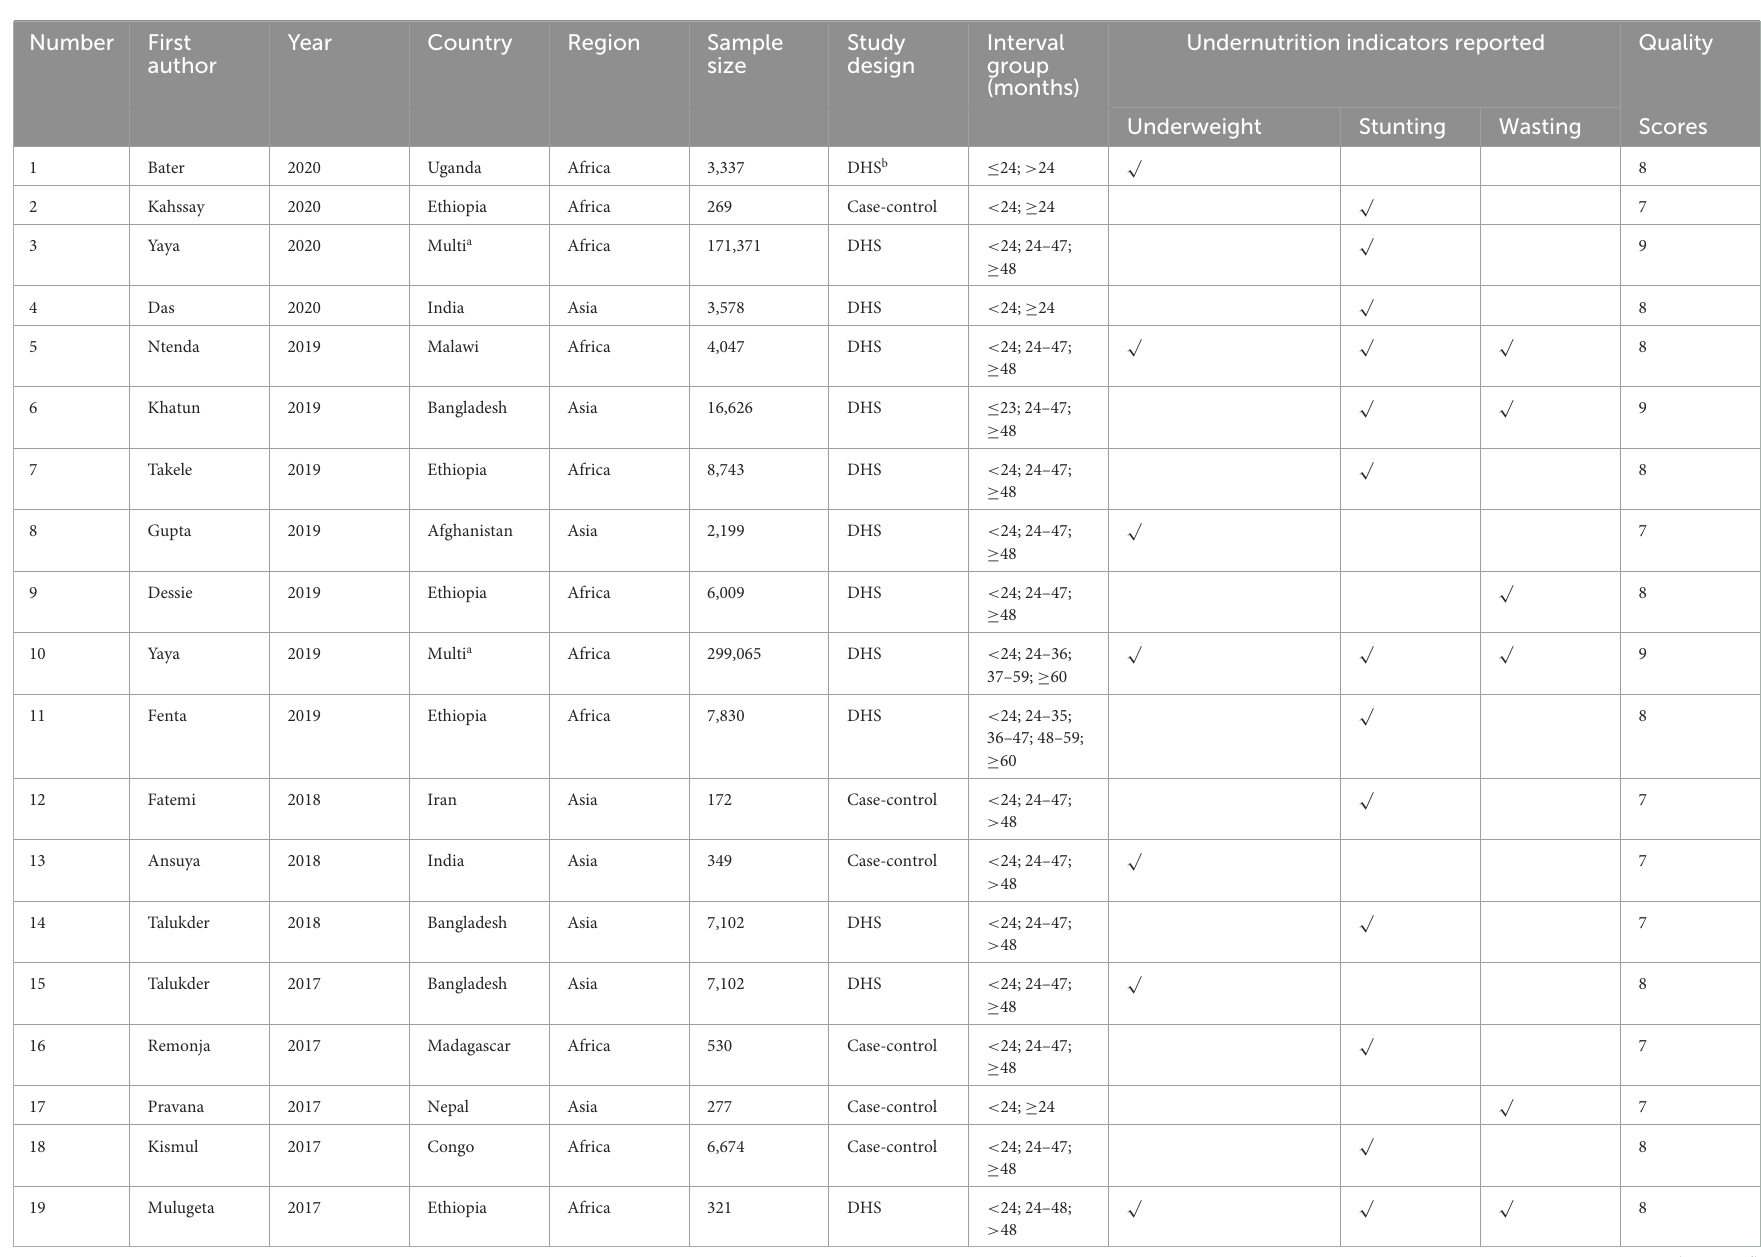
TABLE 1 Characteristics of literature included in the